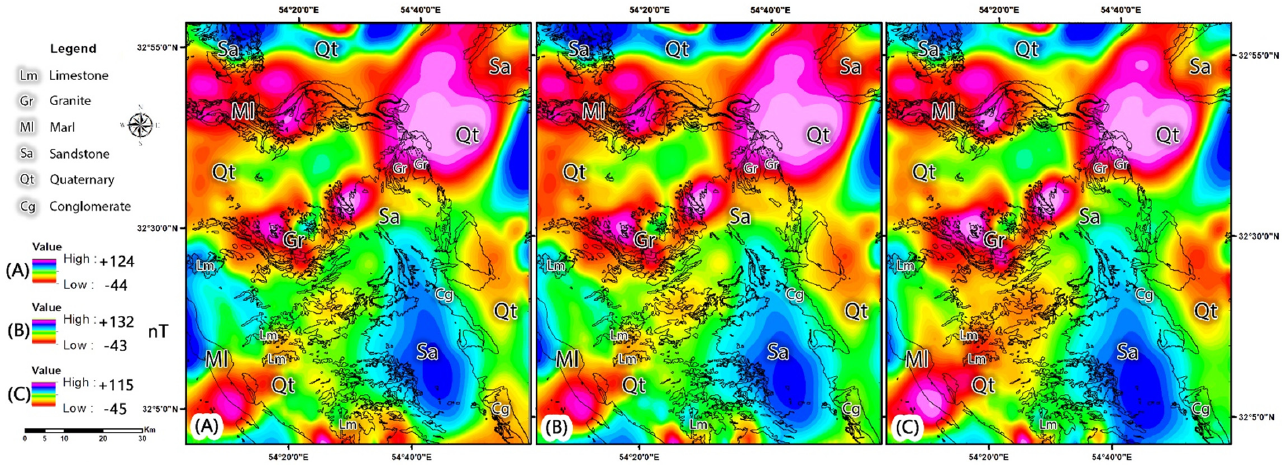
Figure 7. Residual map derived from trend removal filter. ( A ) one-degree, ( B ) two-degrees, ( C ) three-degrees.